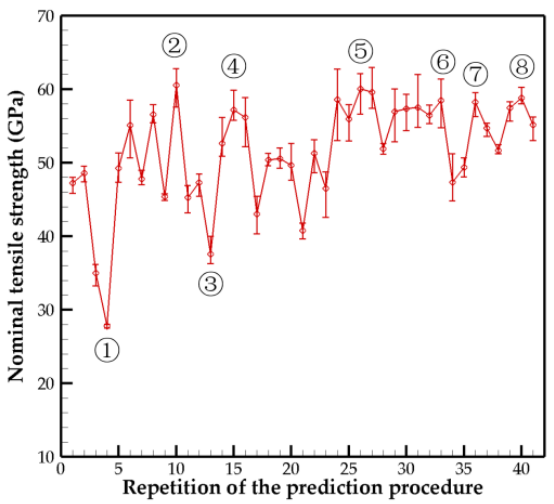
Figure 3. Strength results of the machine learning–predicted structure with respect to the repetition of the prediction procedure. Error bar shows the maximum and minimum values obtained from the three repetitions of calculations.